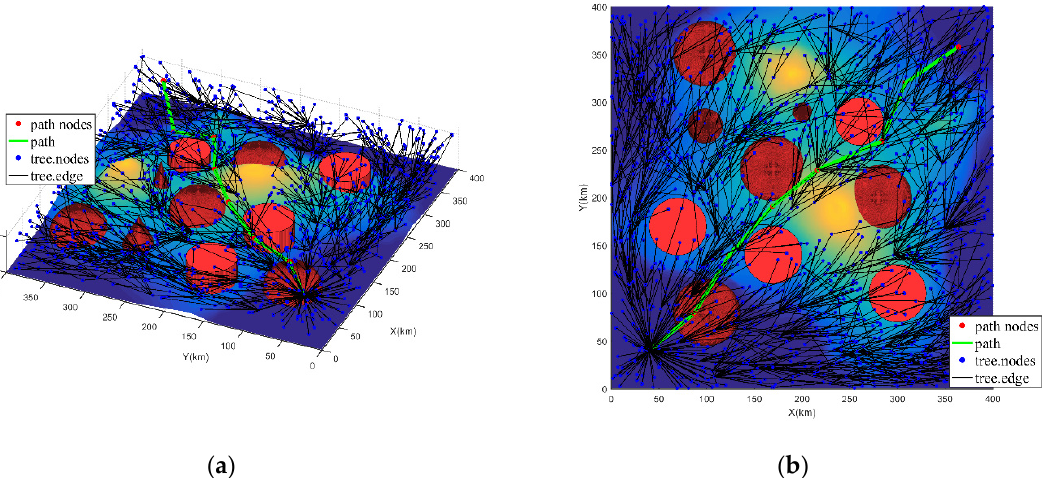
Figure 4. Directed tree graph and path of UAV in Case 2, i.e., λ l = 0.5 and λ t = 0.5: ( a ) 3D view of Case 2; ( b ) 2D top view of Case 2.